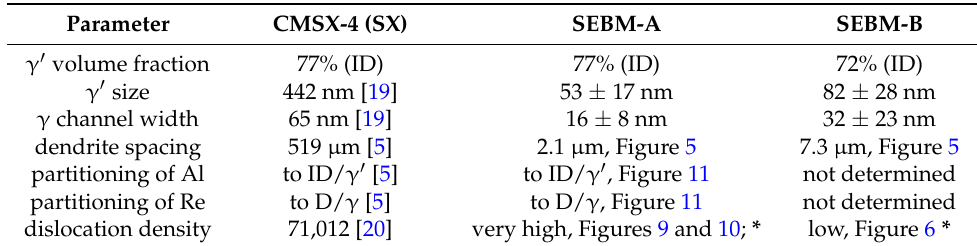
Table 3. Comparison of microstructural parameters (average values) of cast CMSX-4 single crystal and SEBM CMSX-4.